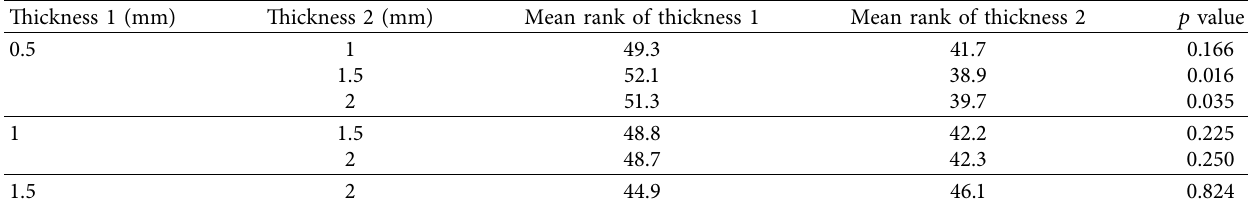
Table 3: The results of the Mann–Whitney U test: comparisons of MA of different